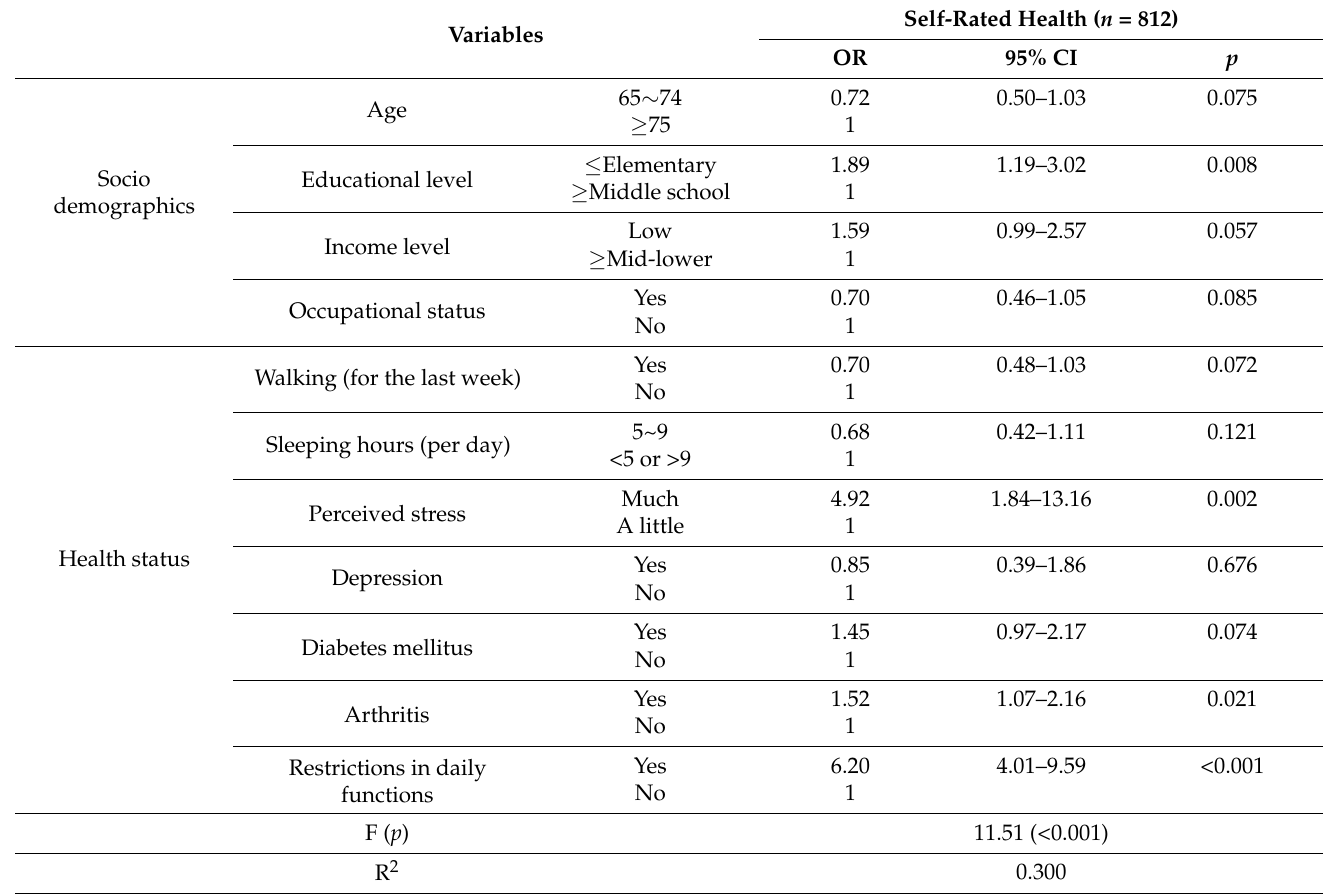
Table 3. Associated factors of poor self-rated